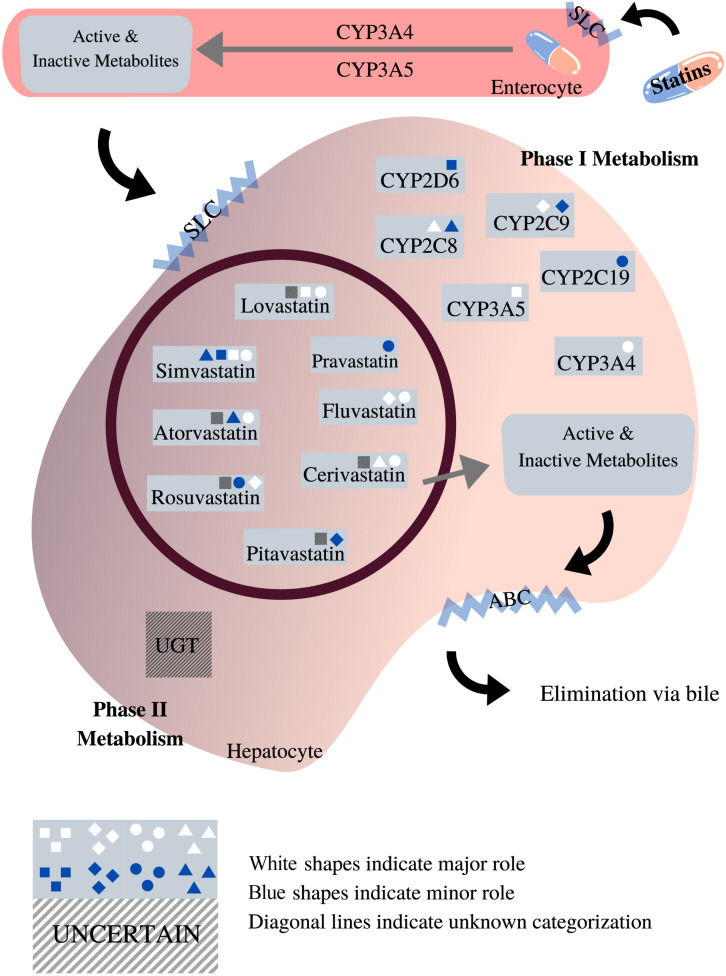
Roles of phases I and II enzymes in statin metabolism [adapted from Goldberg and Roth (1996), Bischoff et al. (1997), Hu et al. (2009), Sirtori et al. (2012), Whirl-Carrillo et al. (2012), Maji et al. (2013), Schirris et al. (2015)]. This diagram depicts the pharmacokinetic pathway of statins, facilitated by endogenous transporters, e.g., SLC and ABC transporters. All statins undergo both phases I and II metabolism prior to elimination. As shown, the impact exerted by different phase I metabolic enzymes on statins varies according to the type of statin. Unlike phase I, the role of phase II metabolic enzymes in statin metabolism is unclear, designed with Canva.com.